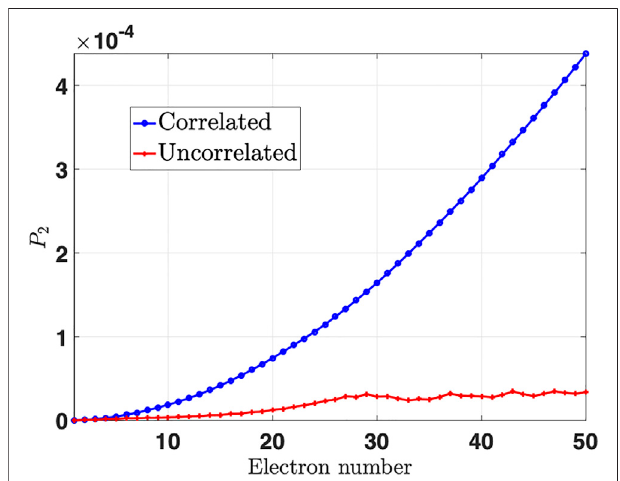
FIGURE 6 | Numerical simulation results of the transition probability P 2 based on the quantum density matrix model (solution of the Schrodinger Equation 1 ) in the cases of modulation-correlated and random QEW beams. In the fi rst case (modulation correlated QEWs), the centroids of the QEWs arrive at the FEBERI interaction point at a random time t 0 j , but the modulation phase ϕ 0 of all of them is the same. This results in quadratic scaling of the TLS excitation build-up (blue curve). In the second case (an entirely random beam of modulated QEWs), the scaling of the TLS excitation build-up is a noisy linear curve (red). In comparing these curves to the semiclassical model results of Figure 4 , note that the horizontal axis here represents electrons number rather than